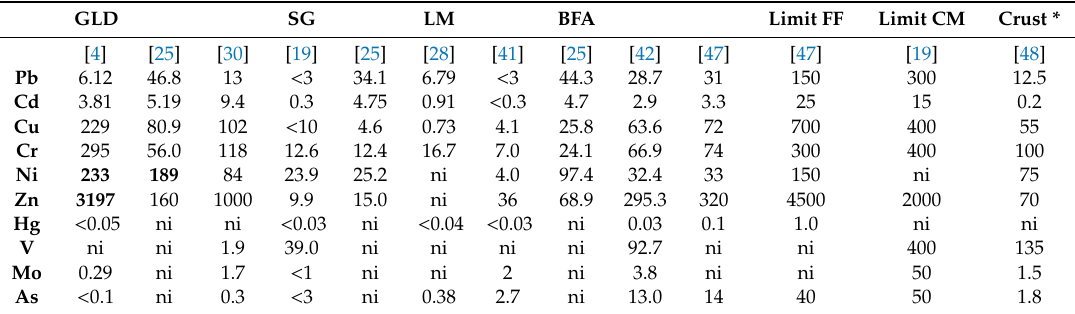
Table 5. The total content of potentially toxic elements (mg /